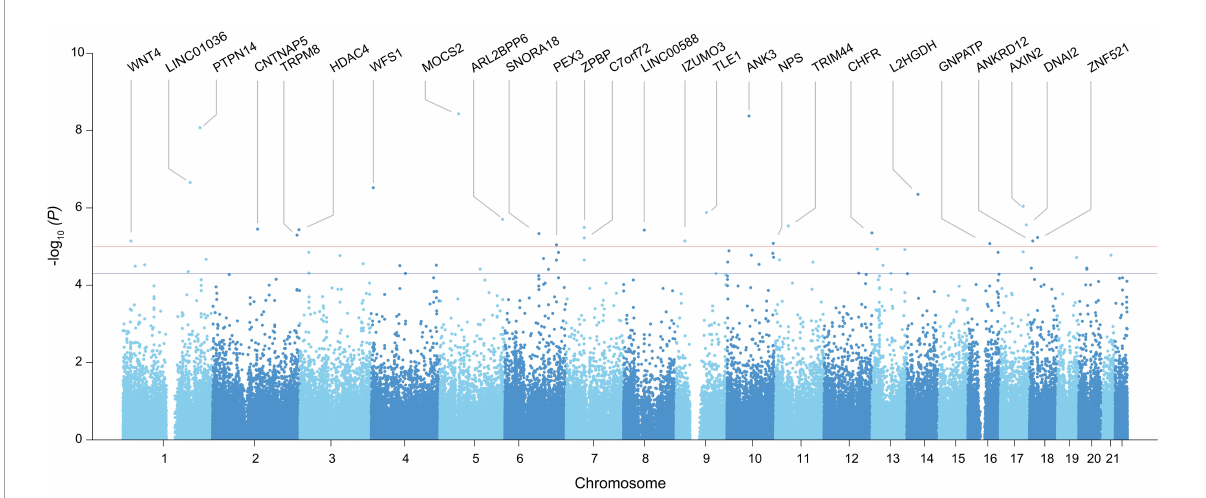
FIGURE1 Manhattan plot of GWAS identified in the entire genome for vascular endothelial function. The x -axis represents the chromosome number, and the y -axis represents the p -value converted to -log. Only genes with SNPs exceeding the stringent significance threshold ( P < 1.00E-05) were included in the plot, and the rest of the candidates above the nominal threshold ( P < 1.00E-05) is provided in Table 1